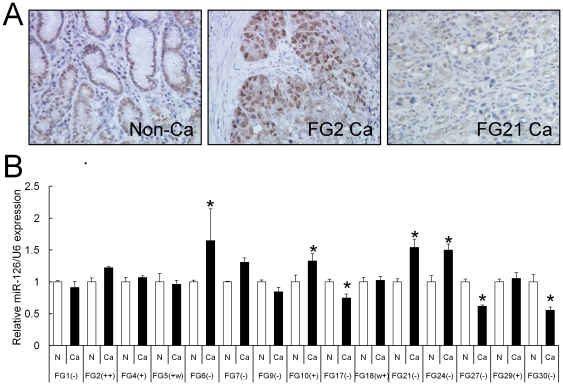
Expression of SOX2 and miR-126 in human gastric cancer tissues.(A) Representative immunohistochemical staining of SOX2 protein in non-cancerous mucosa (Non-Ca) and gastric cancers (FG2 Ca and FG21 Ca). Original magnification: ×400. (B) Quantitative TaqMan real-time PCR analysis for miR-126 was carried out by using the 15 human gastric cancer tissues (filled bars) and paired non-cancerous tissues (open bars). The expression levels of cancer tissues were independently compared to those of paired non-cancerous tissues, which are normalized to 1, and the bars indicate s.d. *P<0.05. The intensities of SOX2 expression were indicated beneath each case by x-axis. The expression levels were determined by the following criteria: “++” for 10% or more cancer cells were strongly stained; “+” for 10% or more cancer cells were stained; “w+” for less than 10% cancer cells were weakly stained; “–” for almost all cells were negatively stained.